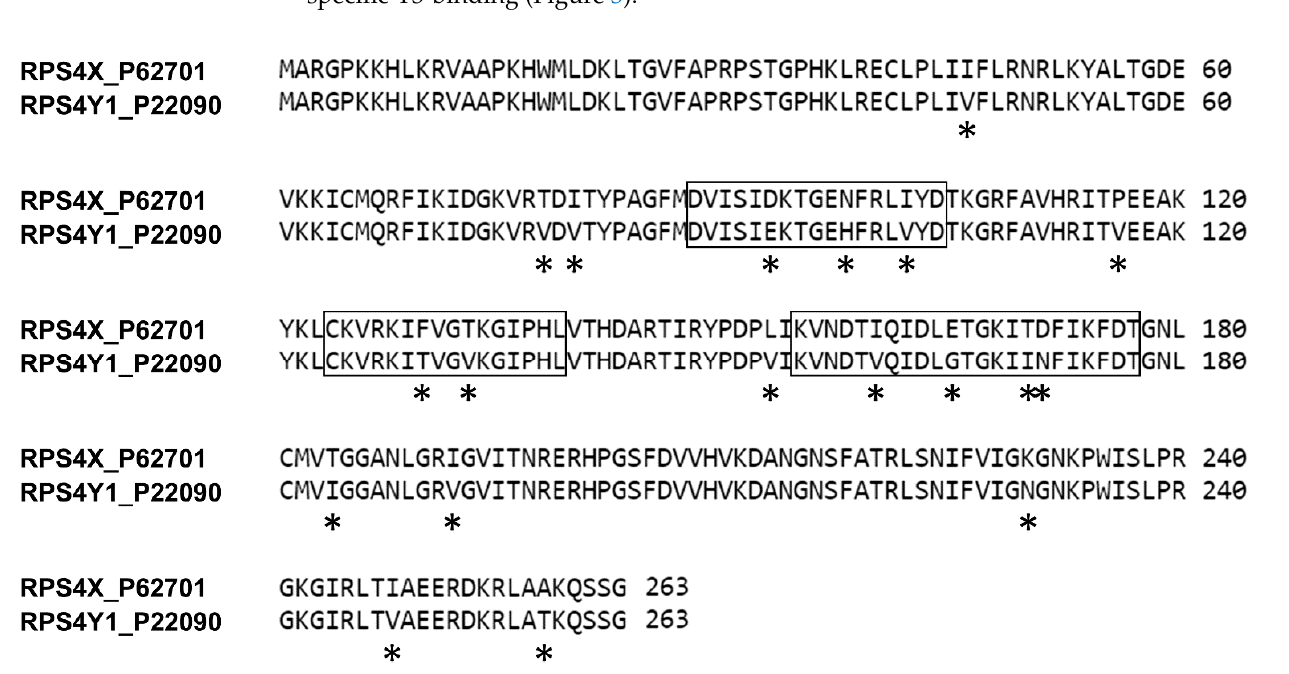
Figure 2. Alignment of RPS4X and RPS4Y1 amino acid sequences. Amino acid difference between the two proteins are indicated by asterisks ( ∗ ). Regions selected as antigens for mice immunization are boxed.